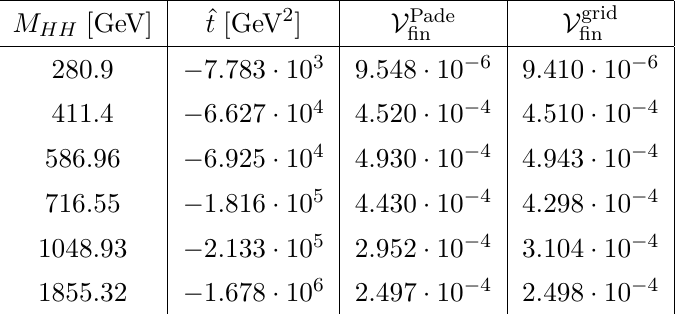
Table 1. Comparison of various numerical values of V fin taken from the grid of ref. [34] with our Padé